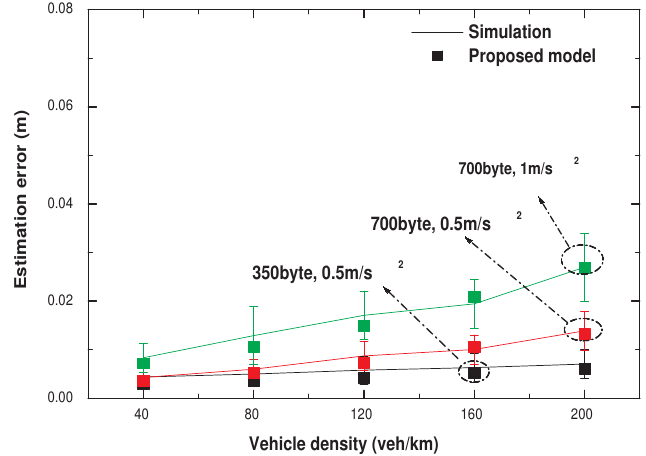
Figure 5. Comparison between numerical results of our model and those of the NS-2 simulation as vehicle density varies with various (a size of a beacon, acceleration) settings: (1) 350 byte, 0.5 m/s 2 ; (2) 700 byte, 0.5 m/s 2 ; and (3) 700 byte, 1 m/s 2